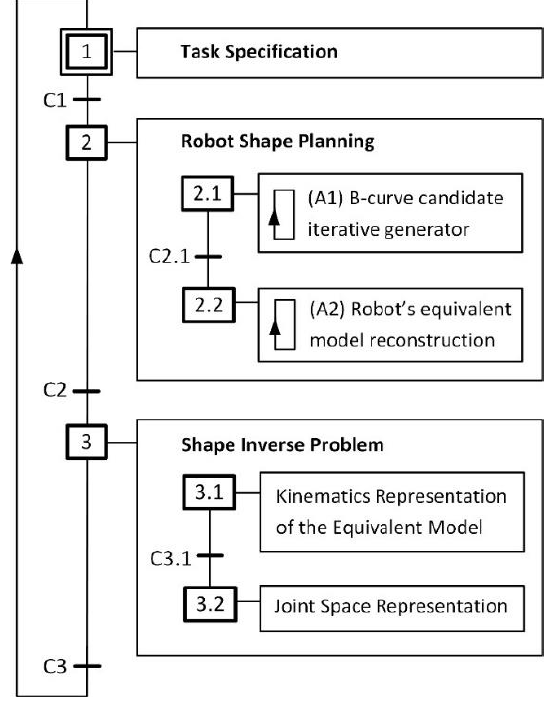
Figure 4. Step processing cycle.